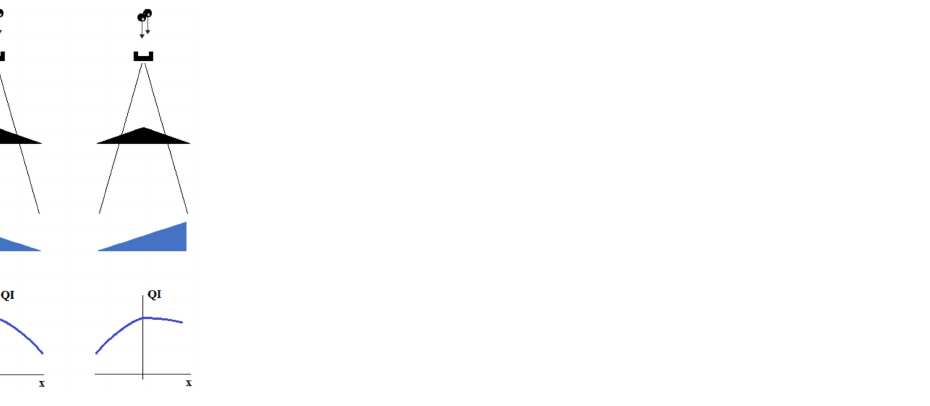
Figure 8. Effect of simultaneous work of flattening filter and hard wedge for both wedge orientations.